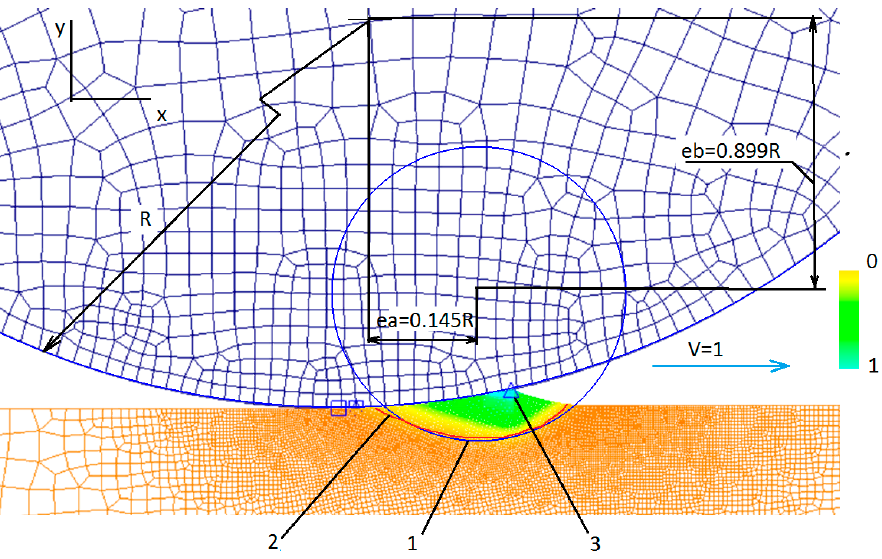
Figure 6. Material displacement area boundaries when burnishing (t = 0.008 mm, R = 2 mm).